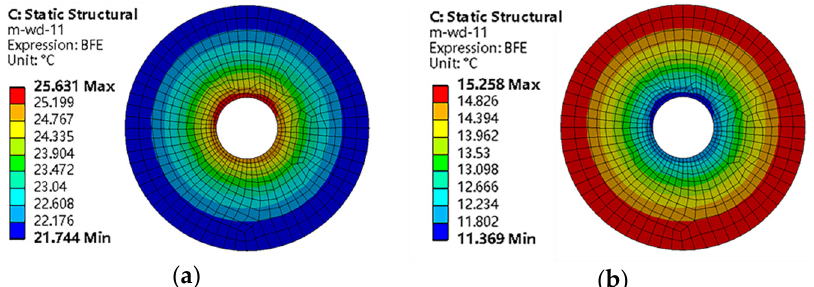
Figure 7. Cross-sectional temperature cloud picture at a position of the pile at depth of 11 m: ( a ) heating condition; ( b ) cooling